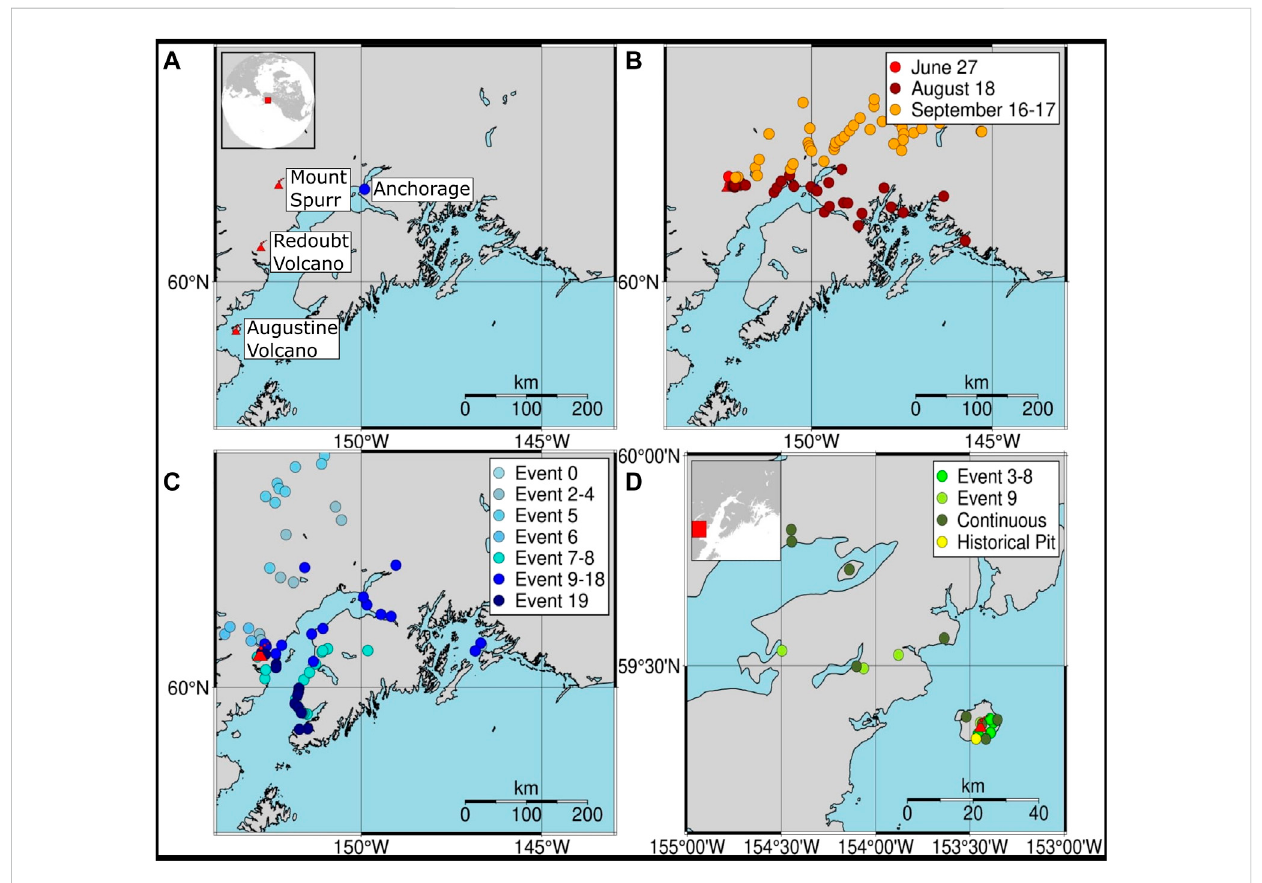
FIGURE 1 (A) Location of studied volcanoes with sample collection locations for (B) Mount Spurr (1992), (C) Redoubt Volcano (2009), and (D) Augustine Volcano (2006). Distinct eruptive events are color coded in the